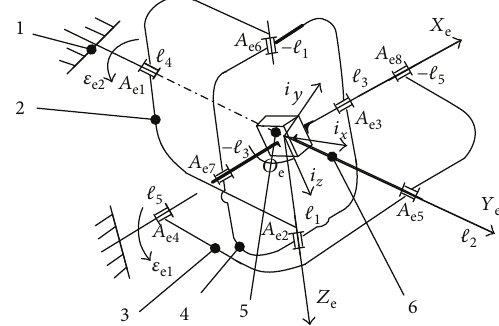
Figure 2: The structure of the biomimetic robotic elbow joint. 1 — frame, 2 and 3 — connecting rods, 4 — annular member, 5 — moving platform, and 6 — arm